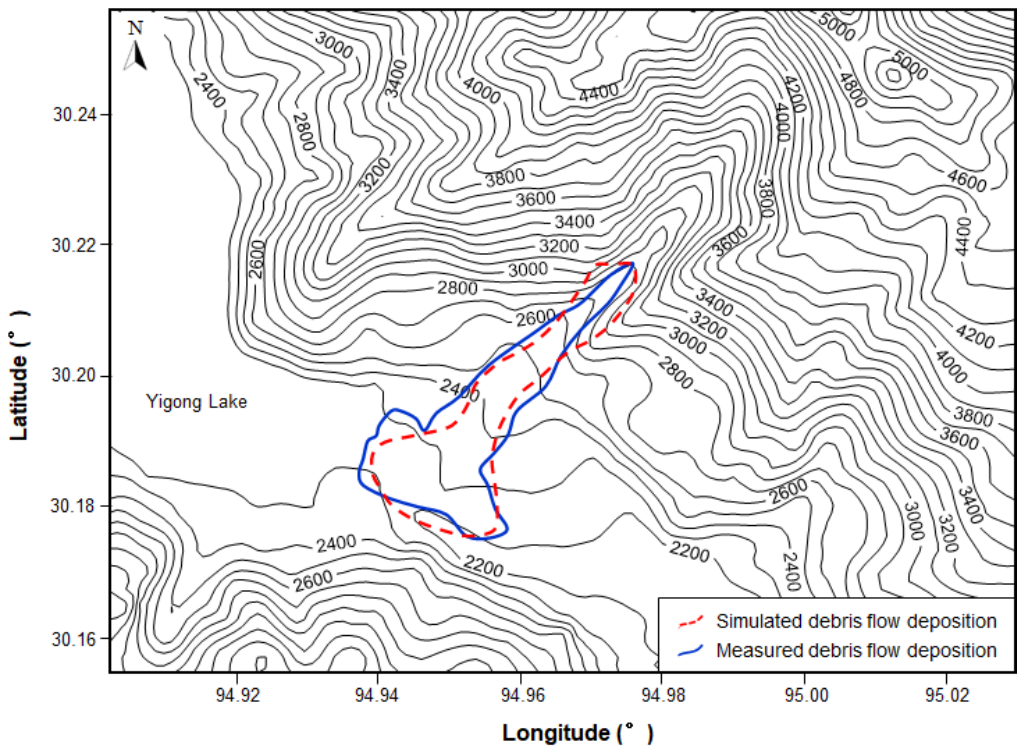
Figure 11. Comparison of the simulated and measured deposition zone of the Yigong debris flow.